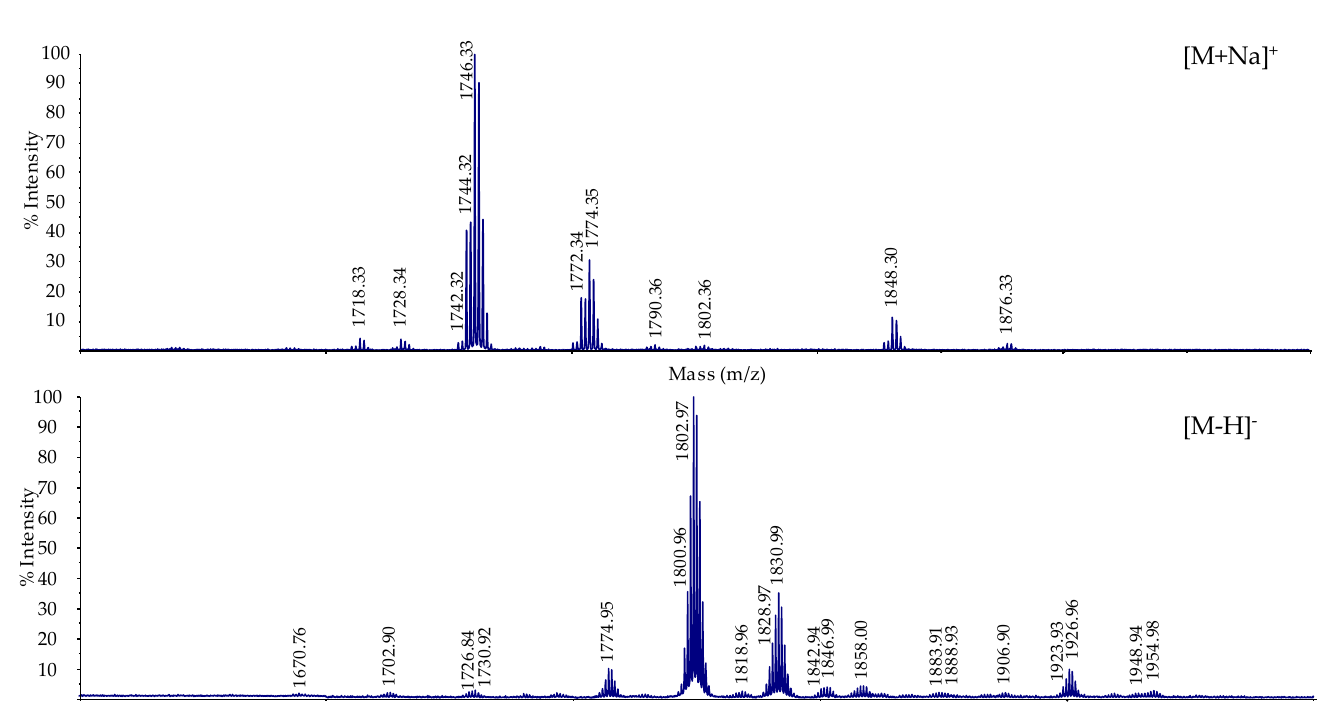
Figure 6. Mass spectrum (MALDI-TOF) of the lipid A released from purified Lcr. LPS. Positive mode is shown on top, negative mode is shown on the bottom. The major ion in the positive mode is a pentaacylated lipid A lacking phosphate with a minor ion representing this species containing a single phosphate. The singly linked phosphate is present as the major ion in the negative mode spectrum. It cannot be ruled out that the major lipid A species in the native LPS is a 1-monophospahte structure, and this phosphate is removed during the mild acid hydrolysis of the lipid A. Table 4. Composition of the prominent ions in the positive and negative mode spectra as seen in Figure 5. Ion Observed Mass * Calculated Mass * Composition ** Positive mode ions 1746.33